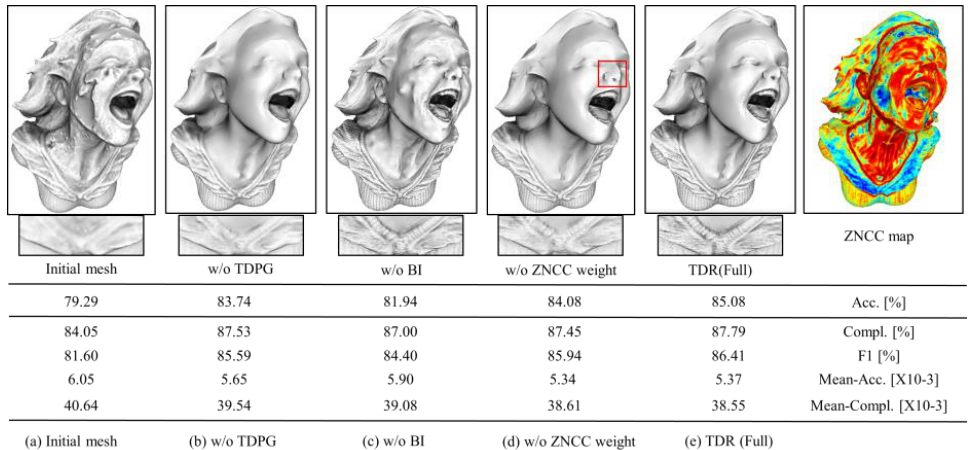
Figure 11. The visualization result and the accuracy metric of the Joyful data.